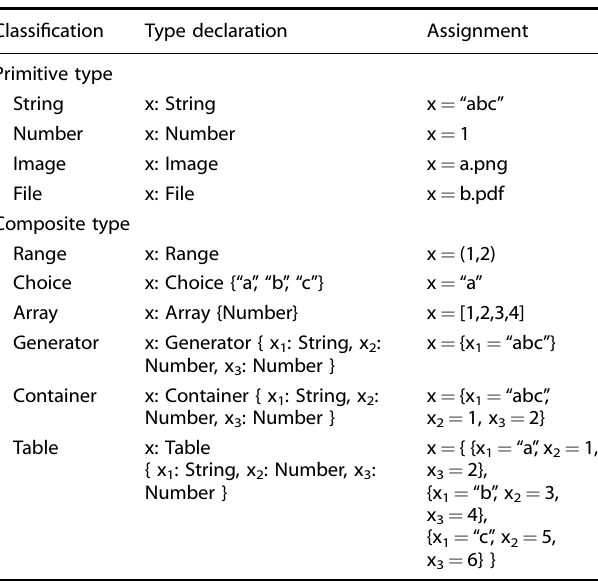
Table 1. Examples of type declaration forms and attribute assignment forms.